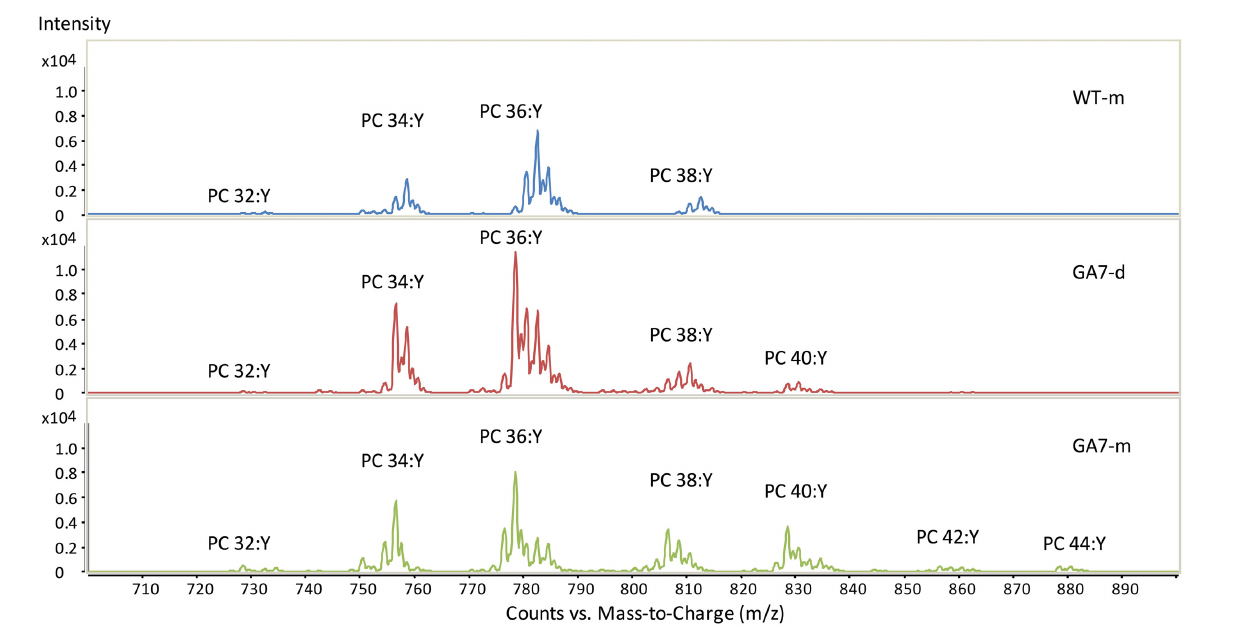
FIGURE 3 | Summed spectra from the precursor ion scan for phosphatidylcholine (PC) from the WT or GA7 Arabidopsis seeds. PC 36:Y indicates PC species with a total of 36 carbons with a total number of Y double bonds in the two acyl chains. Y axis represents the response of ion scan.